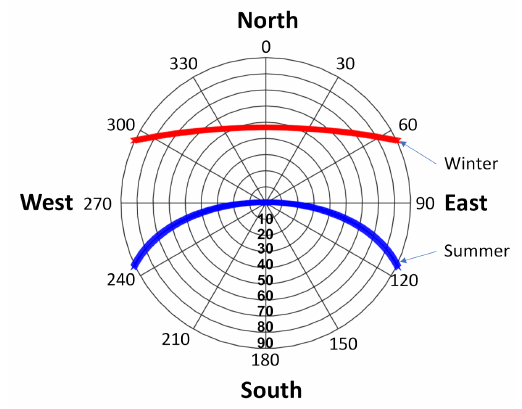
Figure 16. The Sun’s elevation and azimuth angles during winter and summer for a solar PV installation at a 23.5 ◦ S